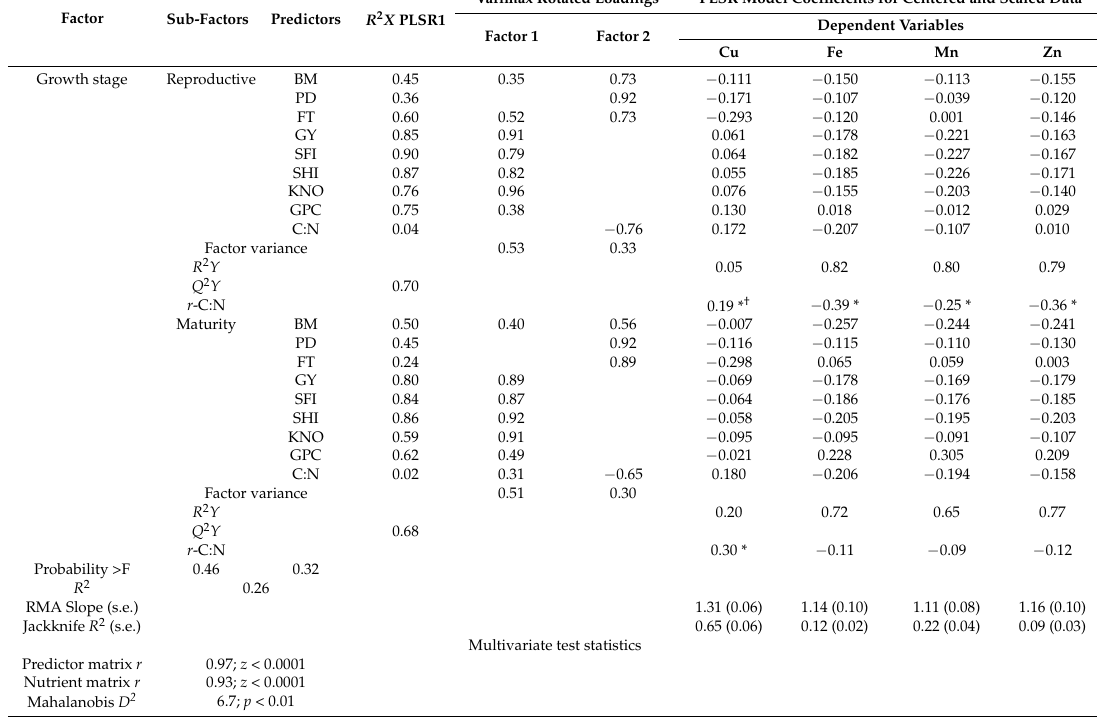
Table 5. Multiple comparisons between reproductive (anthesis + 15 days) and full maturity growth stages of T. aestivum and T. durum , each of three years, using partial least squares regression (PLSR), factor analyses, prediction of micronutrients as functions of phenotypic plasticities, multivariate distances, and matrix correlations between predictors and between predicted